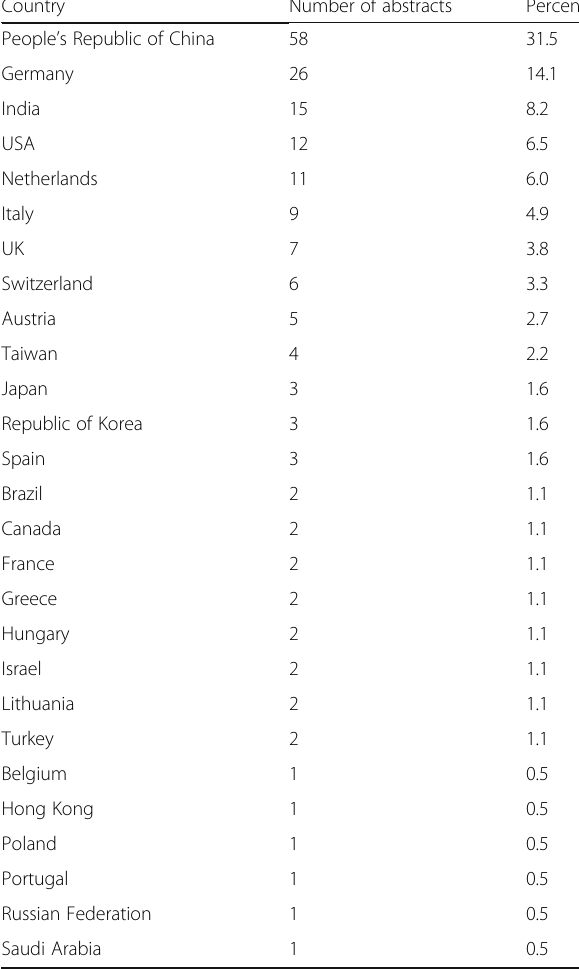
Table 4 Body regions featured in accepted abstracts